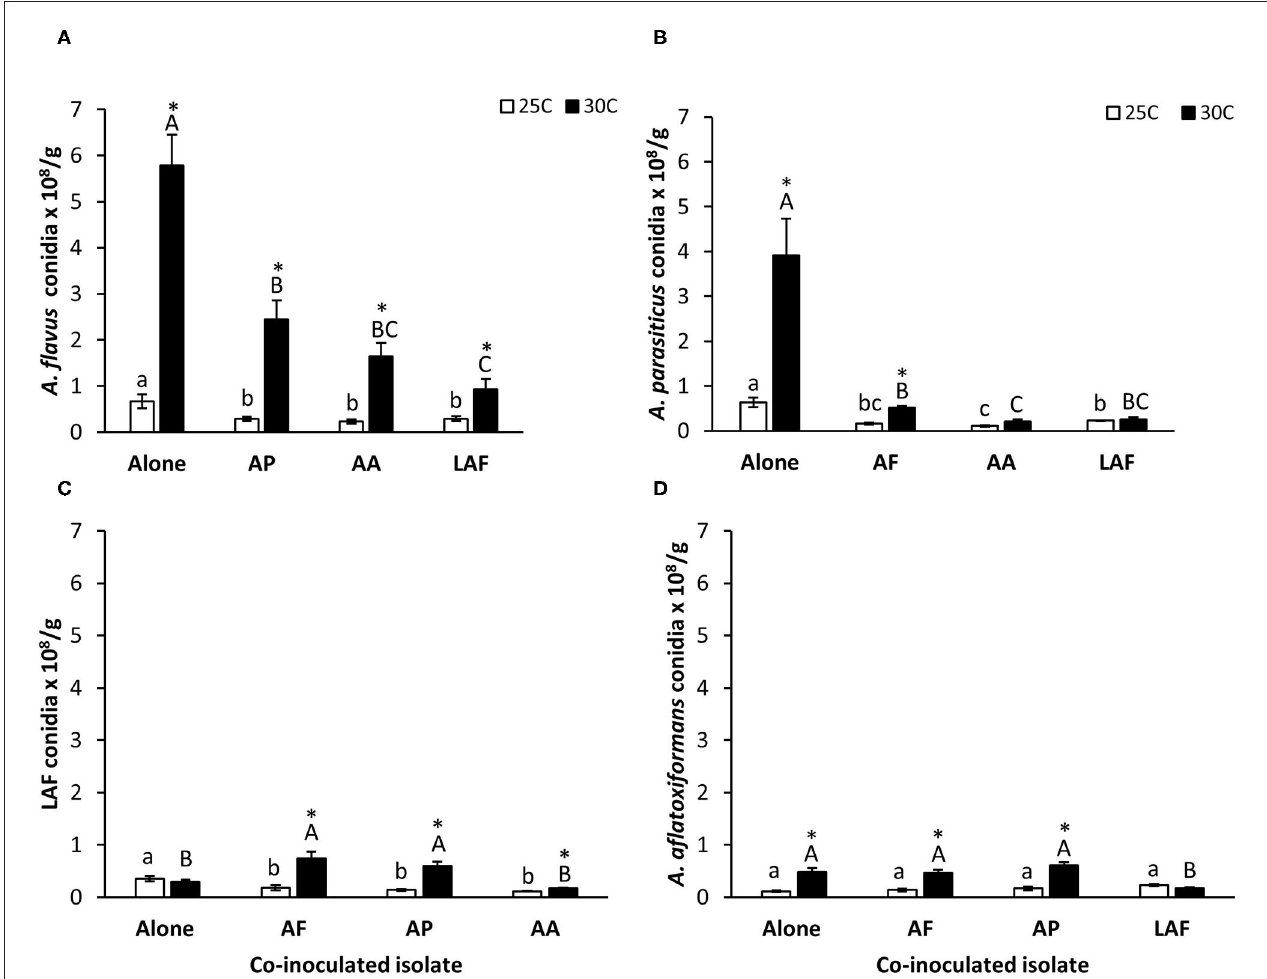
FIGURE 2 | Effect of temperature and co-inoculation of Aspergillus isolates on sporulation during growth on maize kernels at 25 and 30 ◦ C, (A) A. flavus conidia alone and in competition with other isolates, (B) A. parasiticus conidia alone and in competition with other isolates, (C) LAF conidia alone and in competition with other isolates and (D) A. aflatoxiformans conidia alone and in competition with other isolates. AF, A. flavus L strain (AF13) (L-type); AP, A. parasiticus (AP2999) (L-type); AA, A. aflatoxiformans (BN008-R) (S-type); LAF; Lethal Aflatoxicosis Fungus (K0550K) (S-type). Quantities of conidia produced by each species during competition were determined by multiplying the proportion of conidial DNA of each isolate measured using quantitative pyrosequencing by the total number of conidia produced by the co-inoculated isolates. Bars followed by similar letters (lower case letters 25 ◦ C treatment and uppercase letters 30 ◦ C treatment) are not significantly different ( P > 0.05) Tukey’s HSD. Asterisks denote significant difference between 25 and 30 ◦ C treatments ( t -test, P <